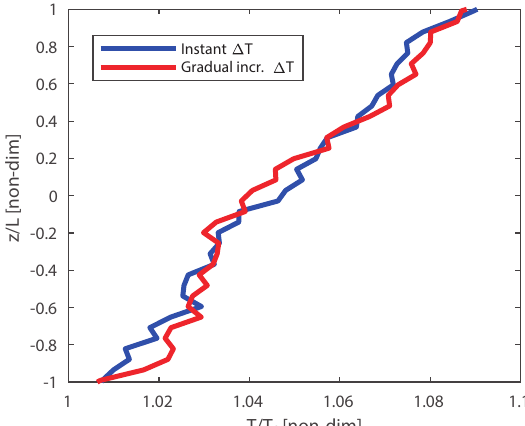
Figure A1. Comparison of temperature profiles (non-dim. T versus non-dim. x ) obtained from ReaxFF-MD simulations for the Pt/Pt interface in the case where the heat source is immediately heated to T H = 330 K (instant ∆ T ) and system in which the heat source is gradually heated to T H = 330 K in steps of 5 K per 1 × 10 5 iterations (gradual ∆ T ).